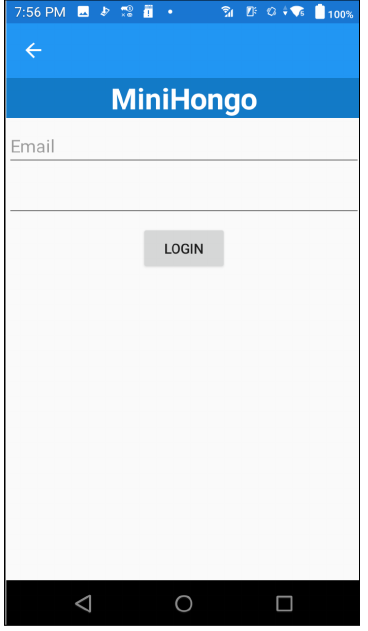
Figure 5. Login page.